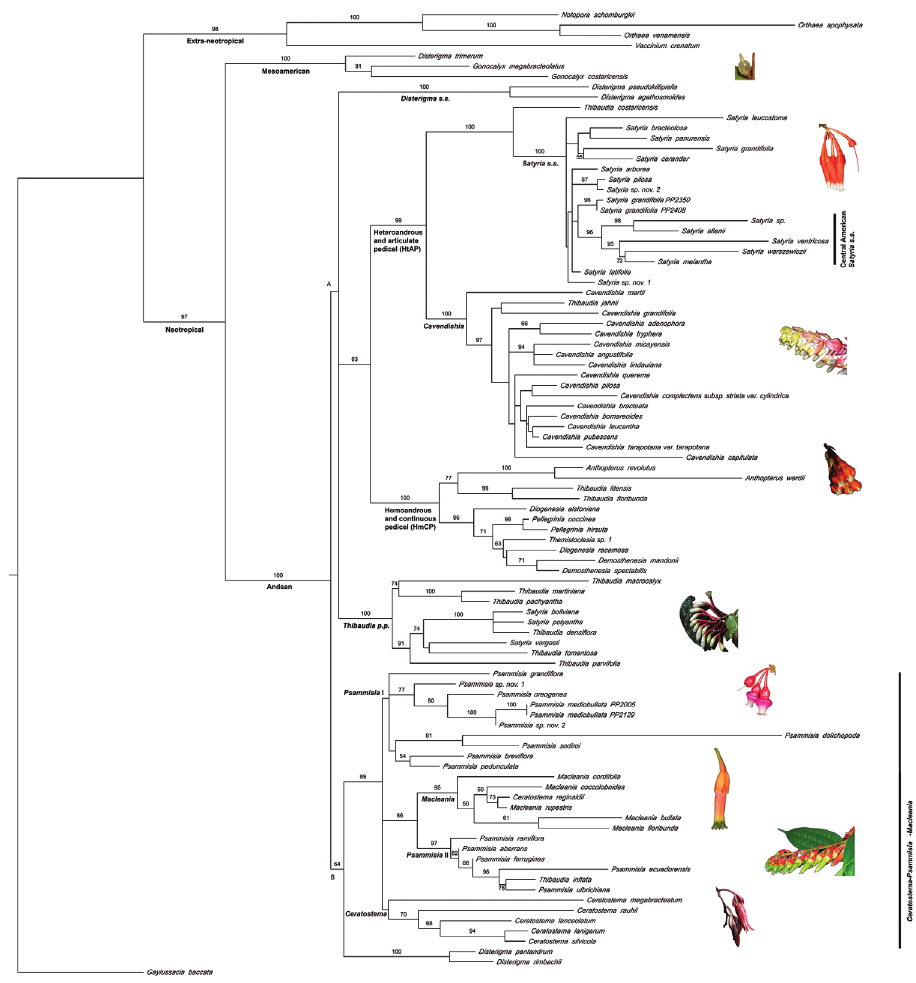
Figure 1. Phylogram of the best found Maximum likelihood hypothesis based on nuclear and plastid se- quence data (ln L = -13984.363979). Bootstrap support values greater than 50% are shown in front of